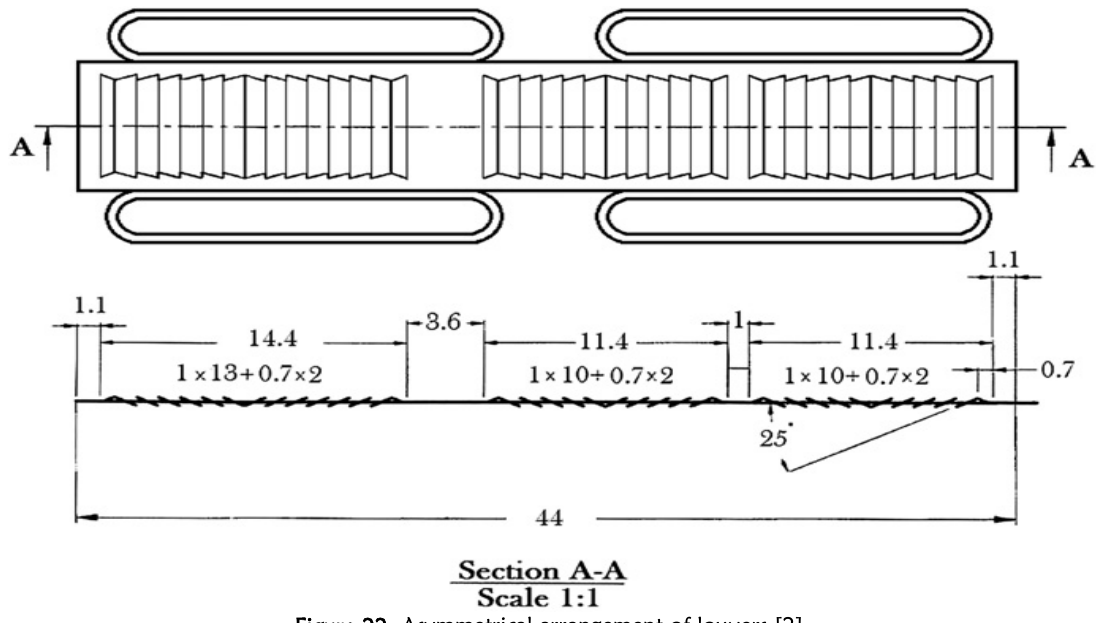
Figure 22: Asymmetrical arrangement of louvers